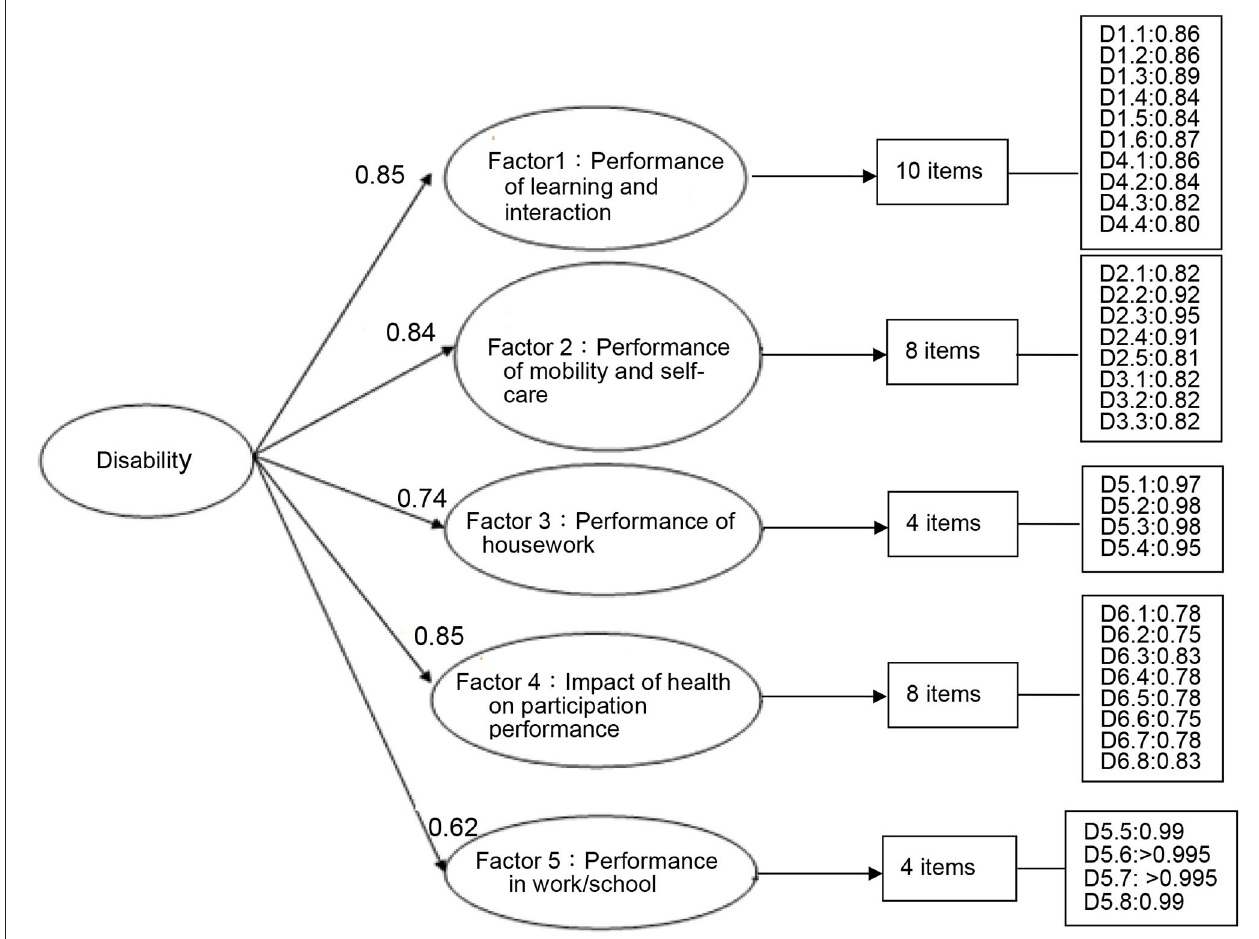
FIGURE 1 | Factor structure of the performance dimension of the FUNDES-Adult, version 7, by the CFA. ( N = 500, 34 items); Fit index (Bollen–Stine bootstrap p -correction estimated): TLI = 0.99, CFI = 0.99, NFI = 0.97, RMSEA = 0.028.